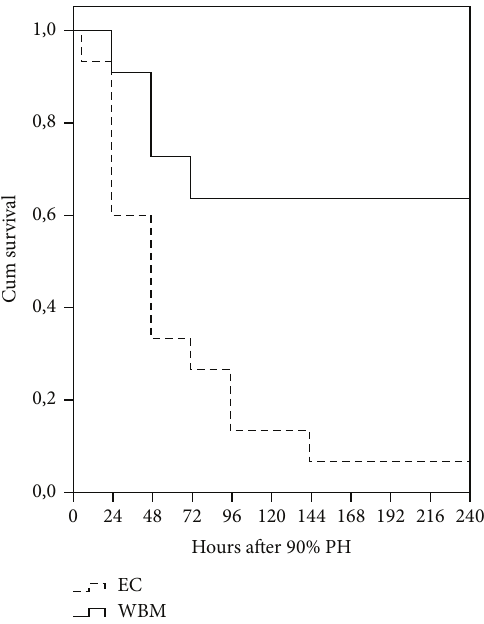
Figure 1: Spontaneous survival according to therapeutic regimen in rats after 90% partial hepatectomy (PH). EC: empty capsules, WBM: whole bone marrow, and Cum: cumulative. Log rank =